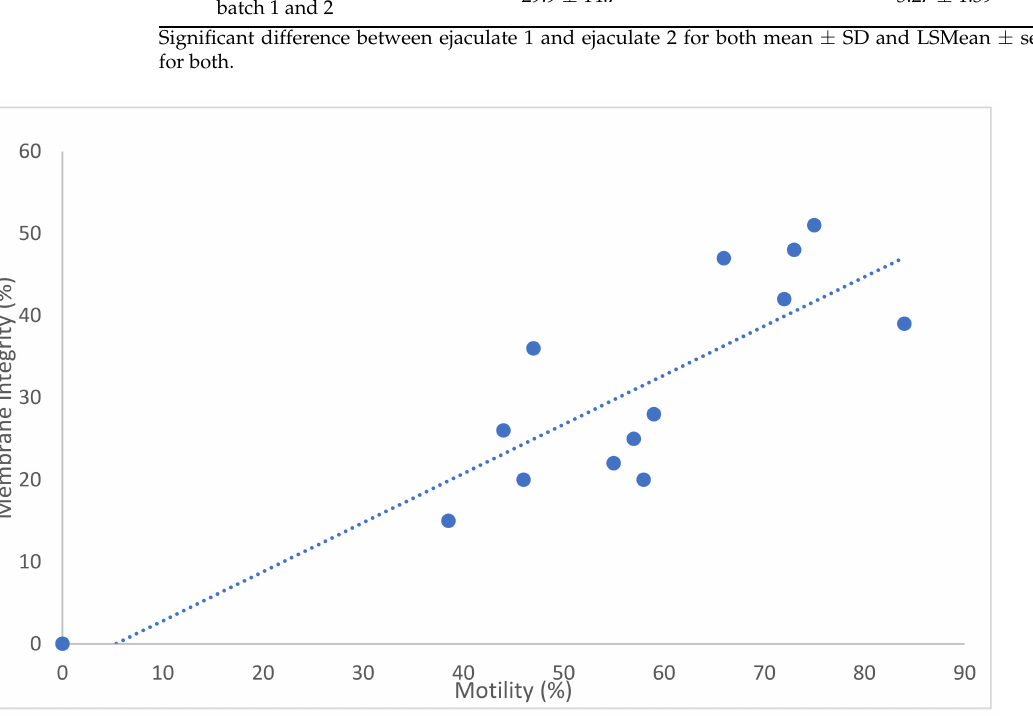
Figure 1. Association between sperm motility and membrane integrity for thawed buck spermatozoa ( n = 14 ejaculates). Note: correlation coefficient r = 0.85; p <